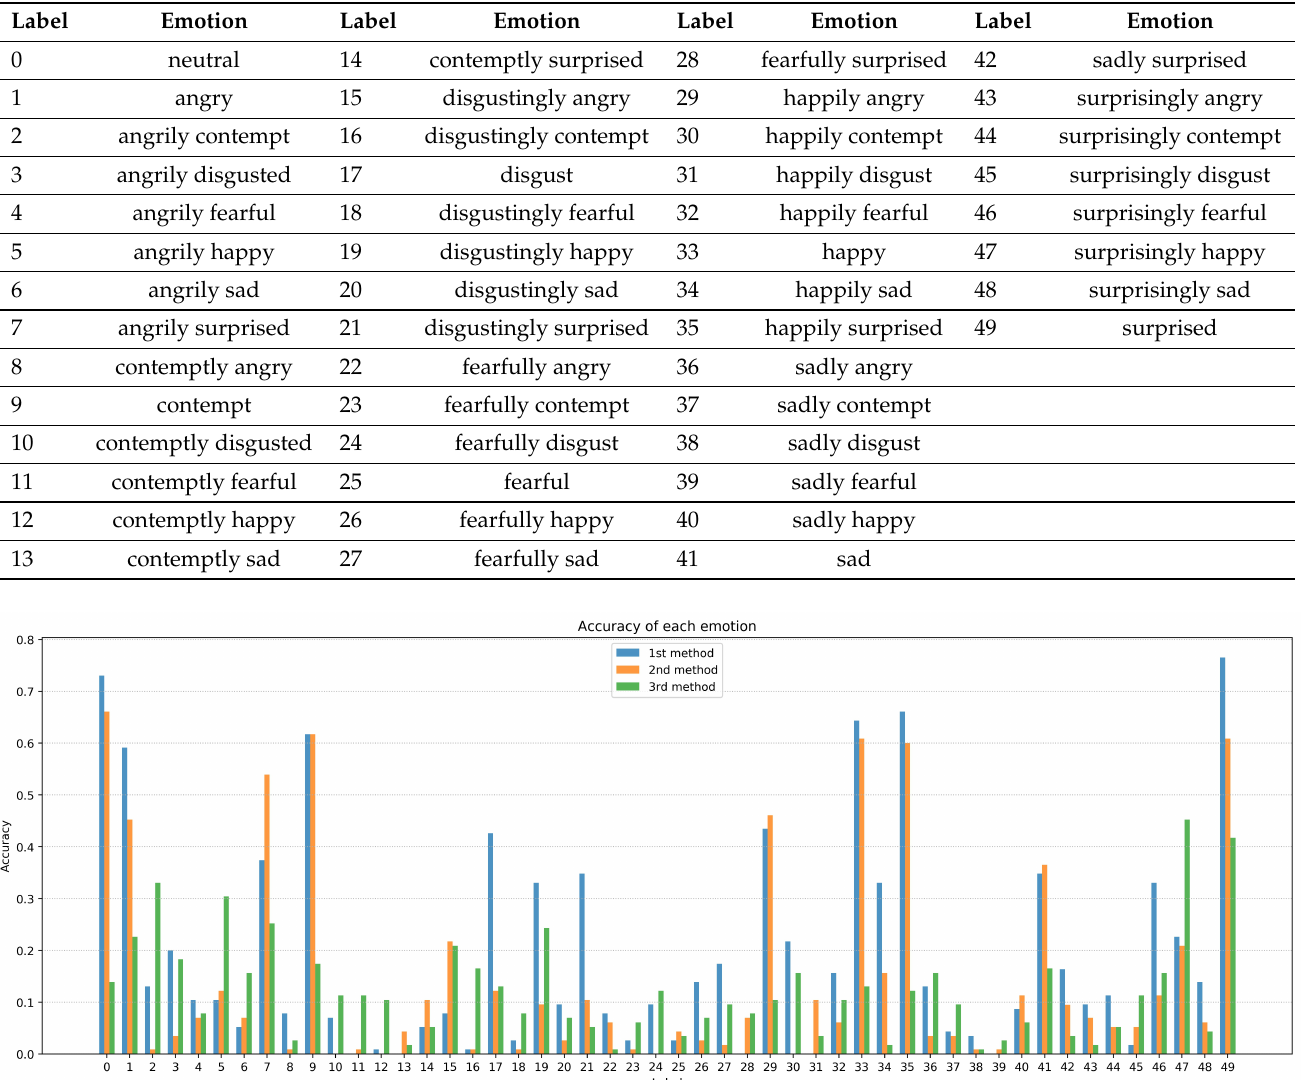
Table 2. The label conversion table.